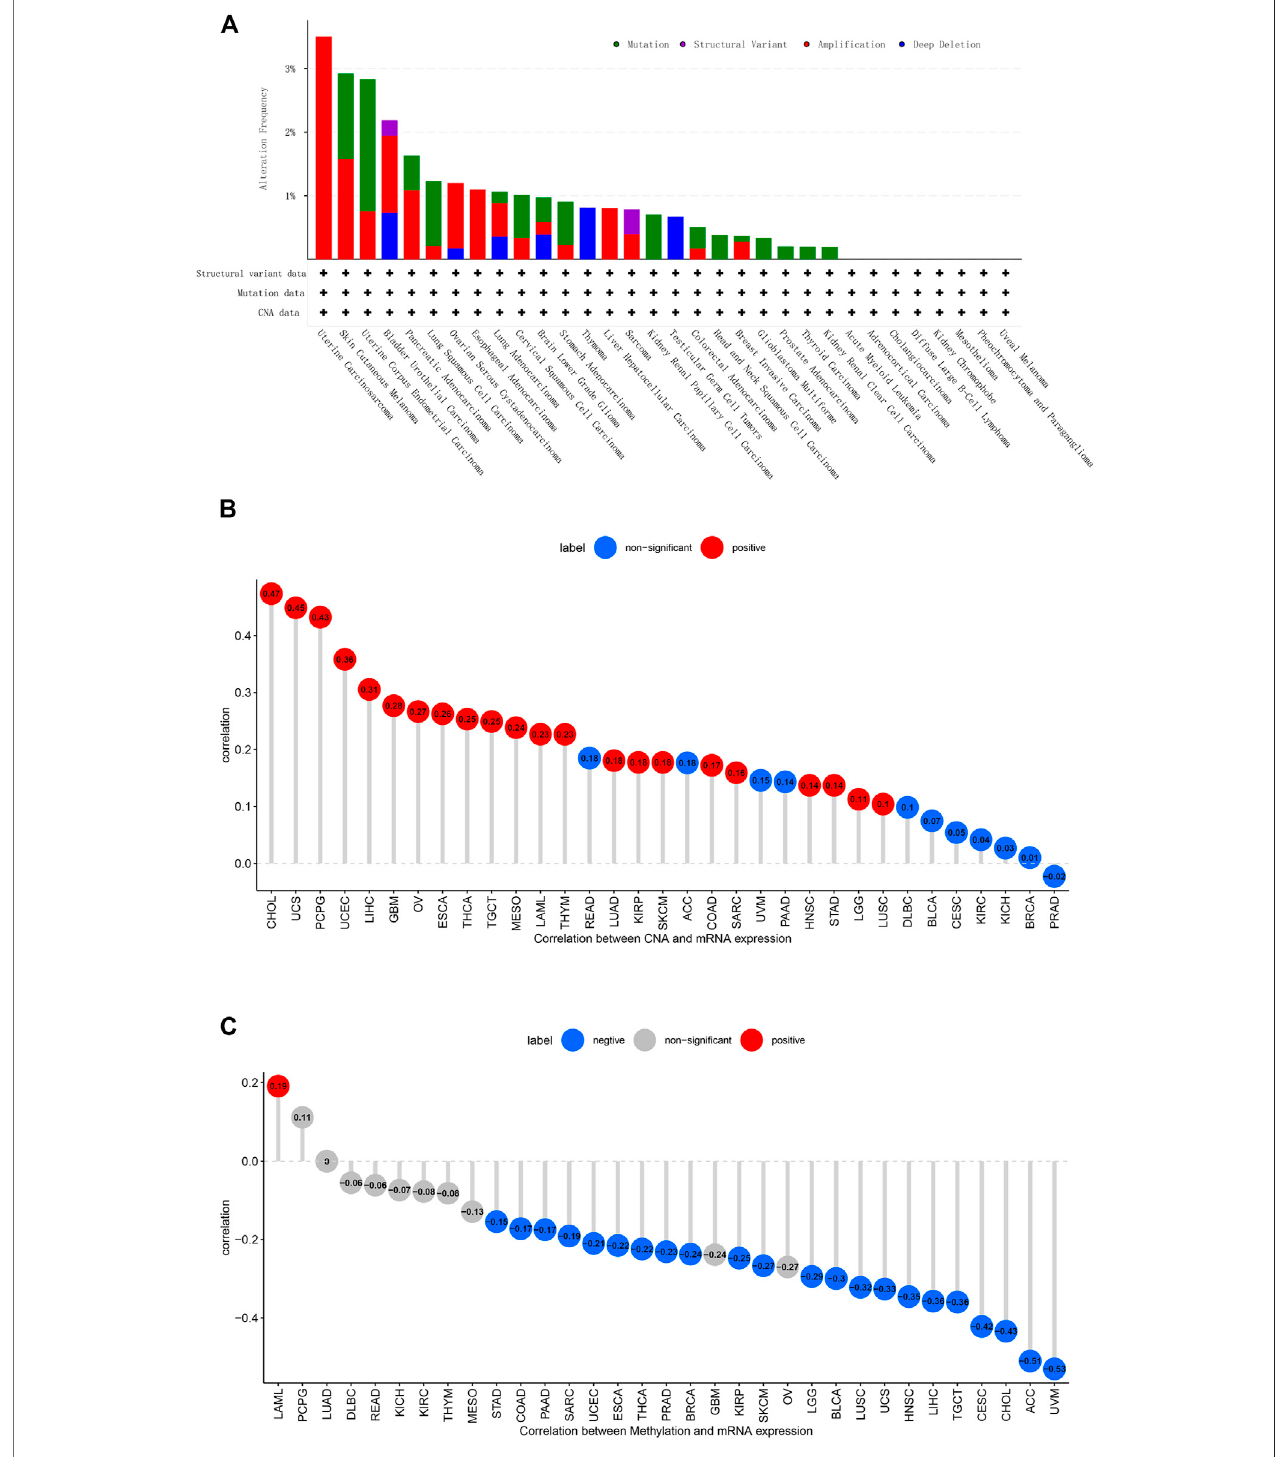
FIGURE 2 | CNA and DNA methylation of C1QTNF6 in pan-cancer. (A) alteration frequency of C1QTNF6 in each cancer of TCGA. (B) C1QTNF6 expression and DNA copy number correlation pro fi le in each cancer of TCGA. The deeper red color means signi fi cant cancer types ( p < 0.05). (C) correlations between C1QTNF6 expression and DNA methylation, the blue represented negatively correlated, and the red represented positively correlated.